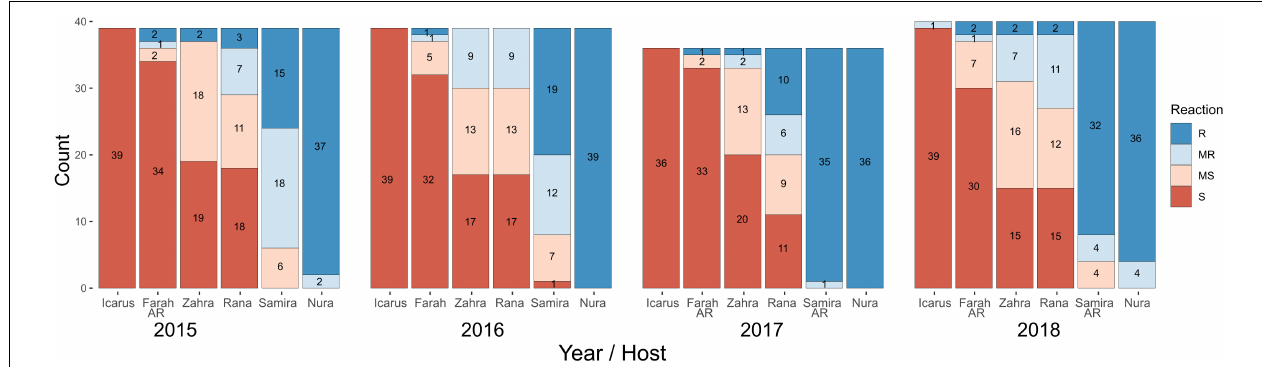
FIGURE 2 | Isolate pathotyping using differential faba bean cultivars. Isolates collected from 2015 to 2018 were screened for disease response using a differential faba bean set that included cultivars: Icarus (susceptible control), Farah AR (2015, 2017, and 2018), Farah (2016), PBA Zahra, PBA Rana, PBA Samira (2015 and 2016), Samira AR (2017 and 2018), and Nura AR. Isolates ( n = 36–40 each year) were classified as resistant (R), moderately resistant (MR), moderately susceptible (MS), or susceptible (S) according to LSD for the respective experiment in which the isolates were tested. Stacked bars show isolate counts for each reaction type in differential